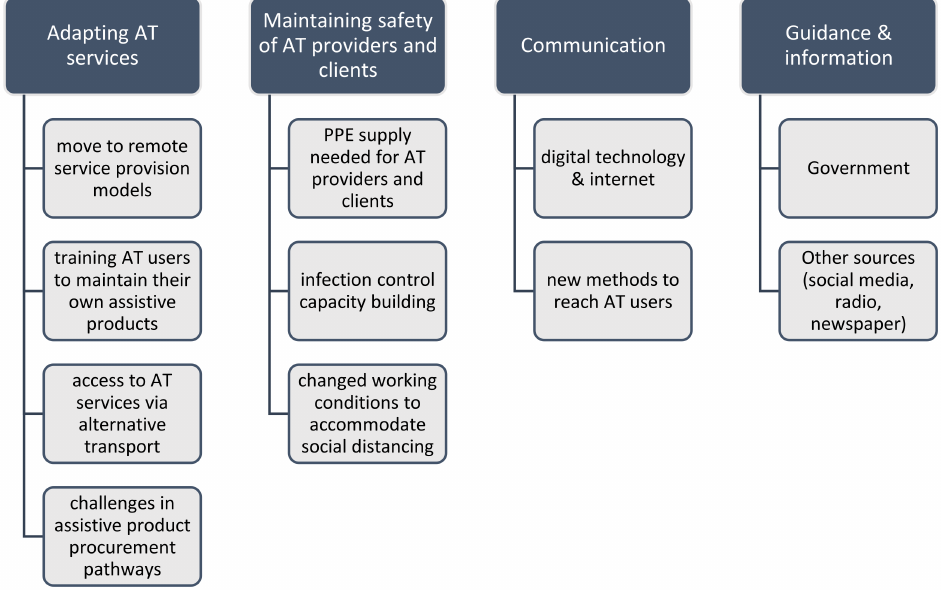
Figure 1. Thematic coding